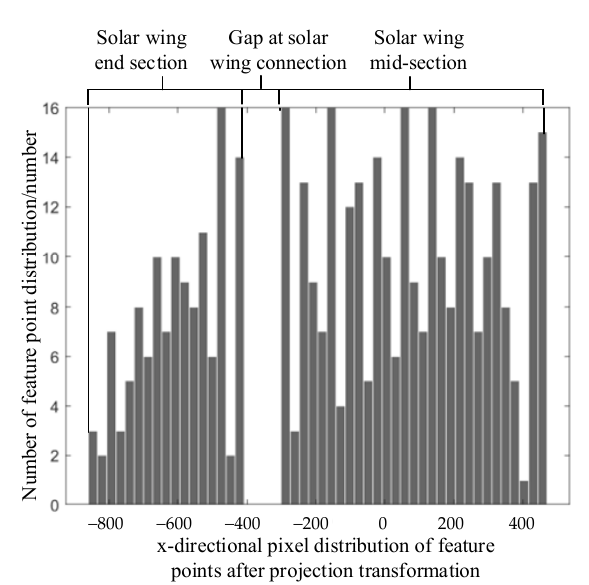
Figure 7. Statistical map of feature point